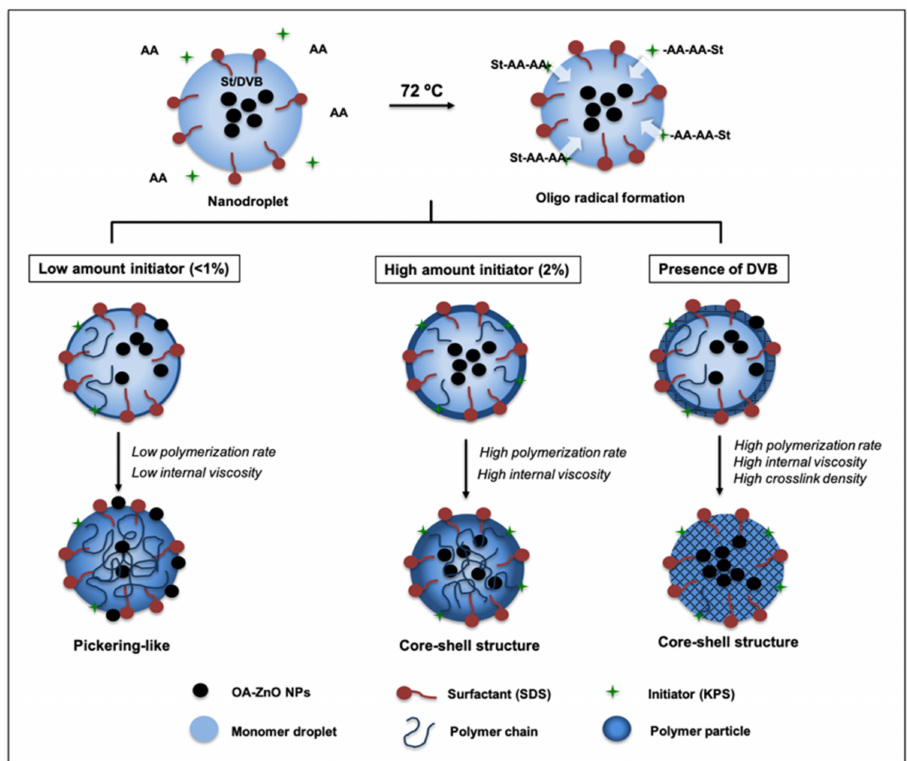
Figure 5. Proposed mechanism for the formation of Pickering-like and spherical